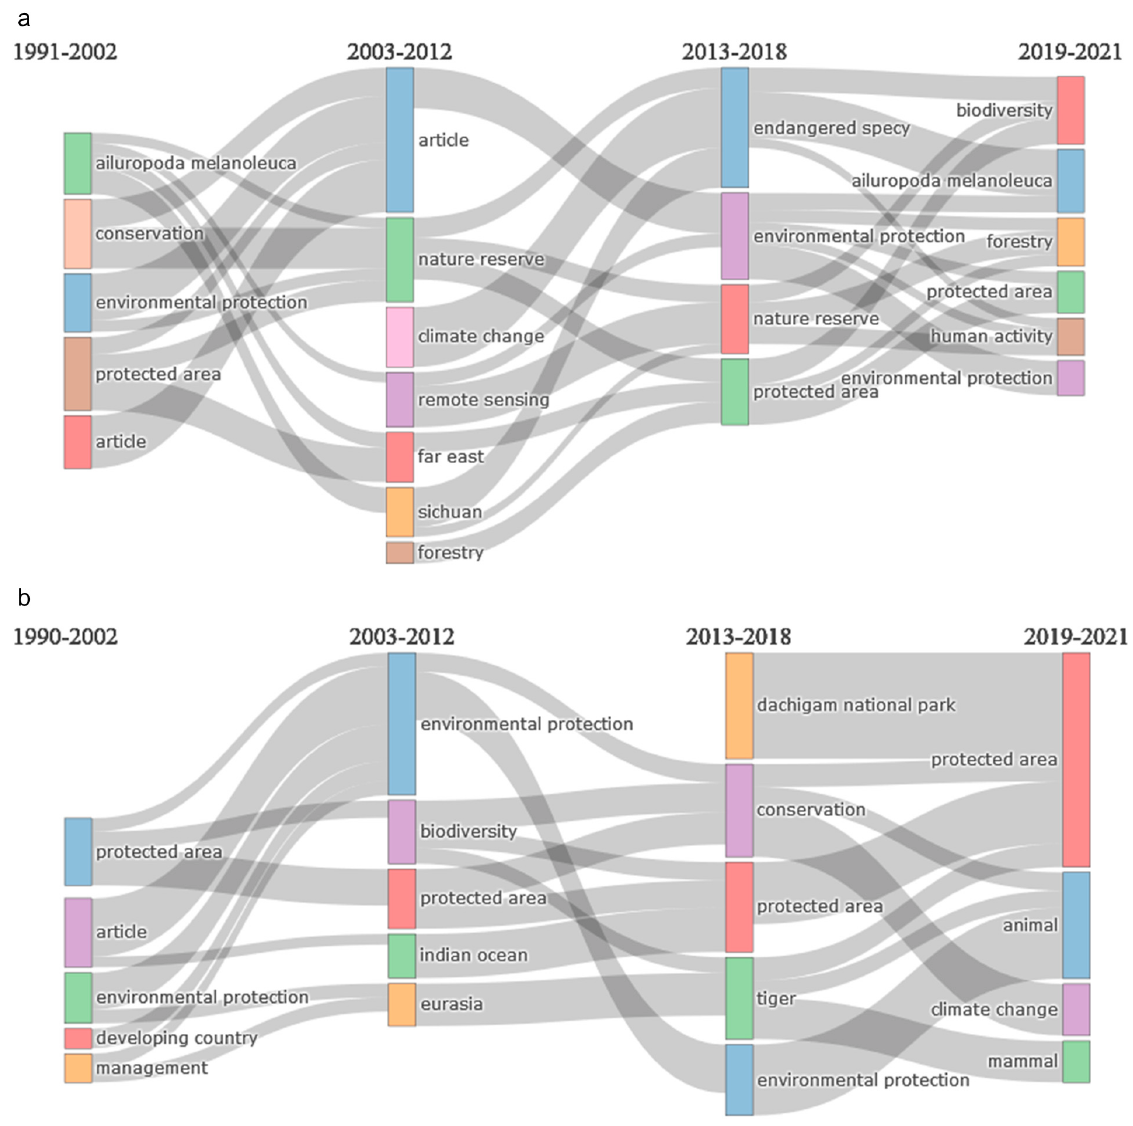
Figure 10. Thematic evolution of CPAP-related publications ( a ) and IPAP-related publications ( b ).